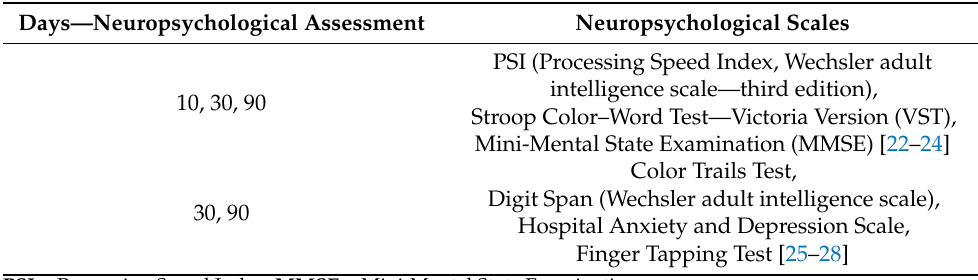
Table 2. Frequency of assessments within the three study